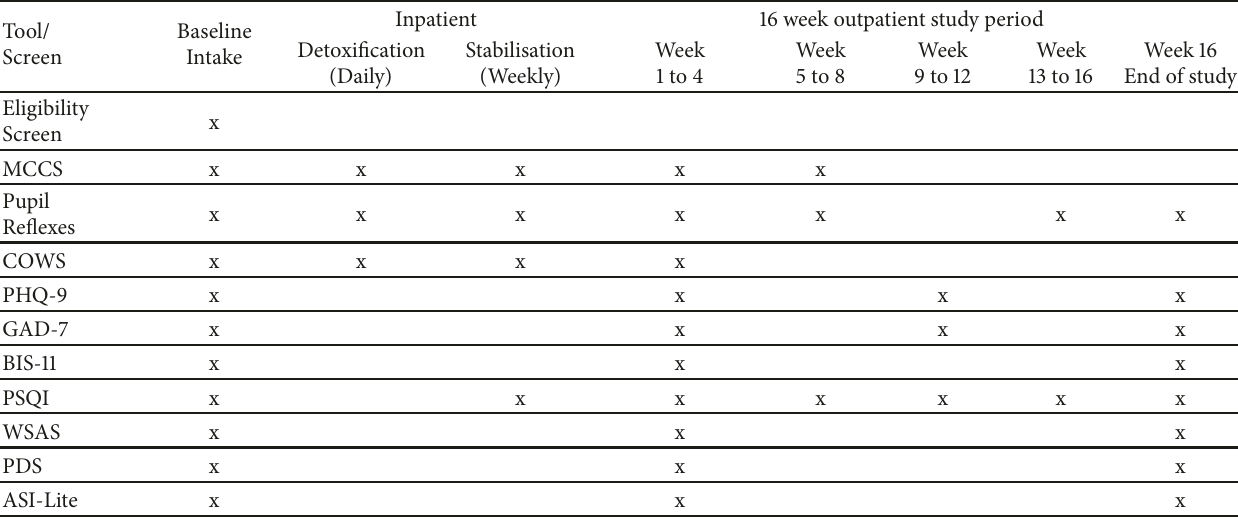
Table 2: Schedule for administering study